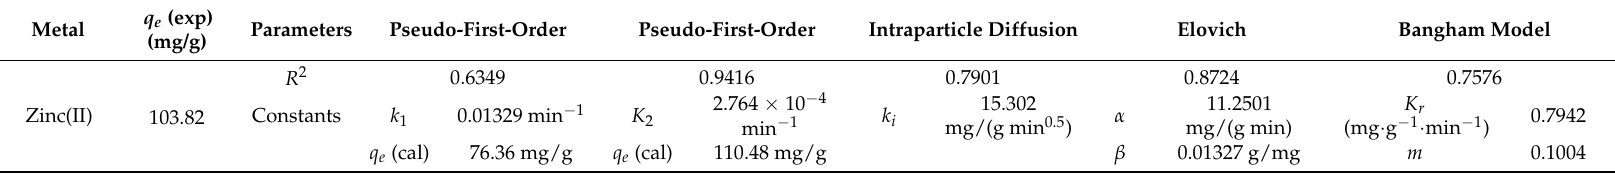
Table 3. Comparison of the estimated adsorption rate constants, q e , and the correlation coefficients of the five kinetic